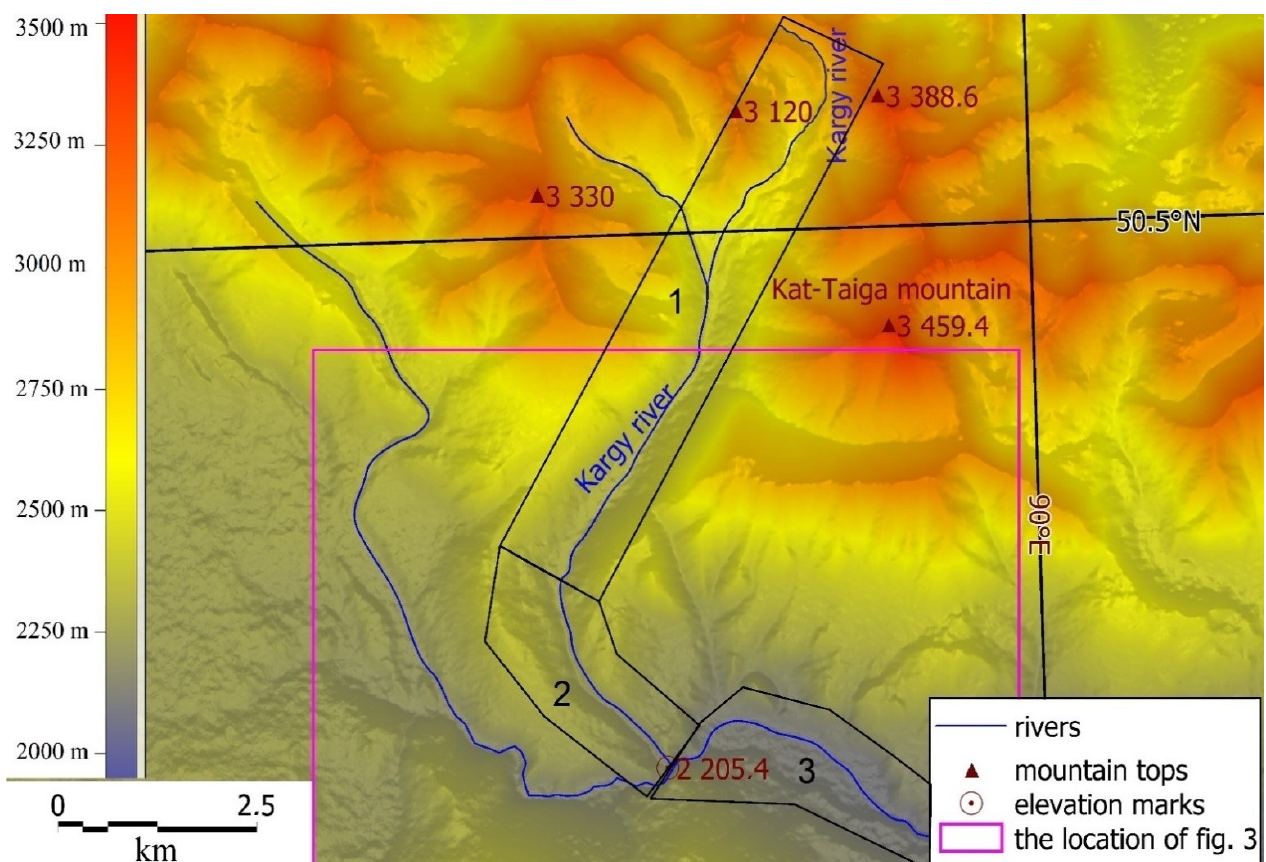
Figure 2. The upper reaches of the Kargy River. Elevation is given on the basis of semitransparent digital elevation model SRTM [64]. The sections of the valley described in the text are shown in